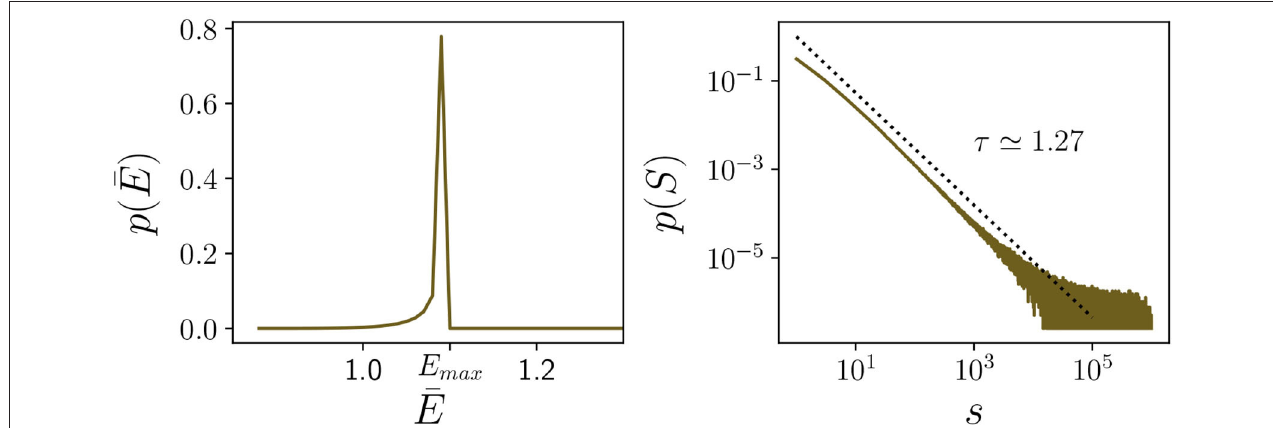
FIGURE A1 | Simulations of the SOqC theory may exhibit scaling similar to that of C-DP. (Left) The probability distribution of the average energy is peaked around E c , but it is much more sprread that the SOC case, owing to oscillations around the critical point. (Right) Distributions of avalanche sizes in this case. The C-DP exponent is shown for comparison. Although a change in trend can be seen around s 10 4 , larger sizes are required in order to clearly see the exponent corresponding ∼ asymptotic scaling (controlled by dynamical percolation, as discussed in the main text). Parameter values are: